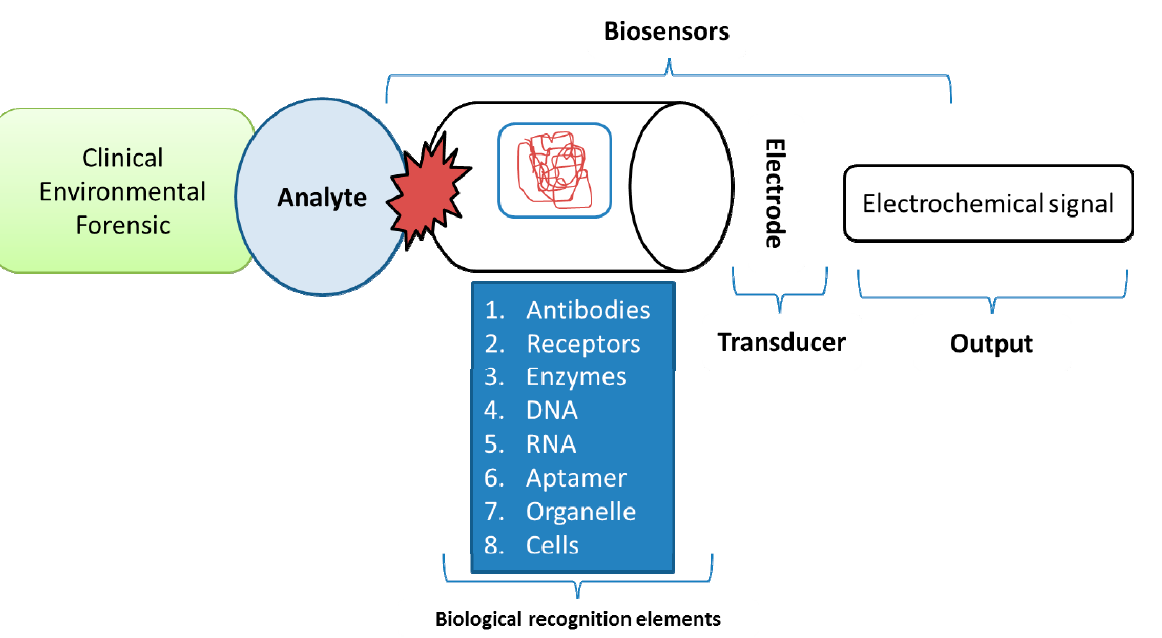
Figure 1. Indicates the fundamental theory of biosensor.